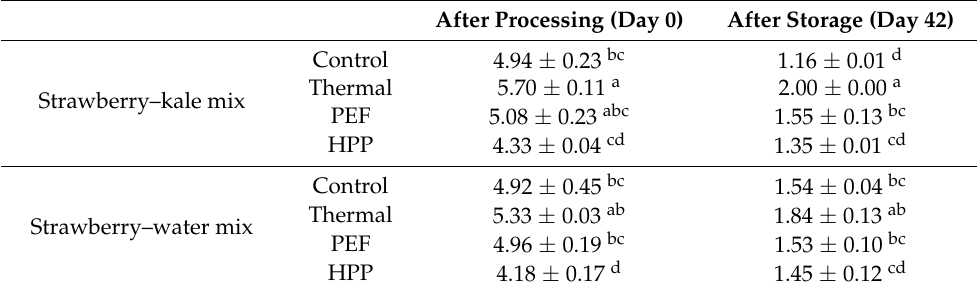
Table 2. Ascorbic acid/dehydroascorbic acid concentrations (mg/100 g) in the strawberry–kale mix and strawberry–water mix directly after processing (day 0) and after the storage (day 42) (n = 2). Different letters indicate significant differences per column. Kale samples exhibited values below the detection limit (1 mg/100 g) and are not reported.